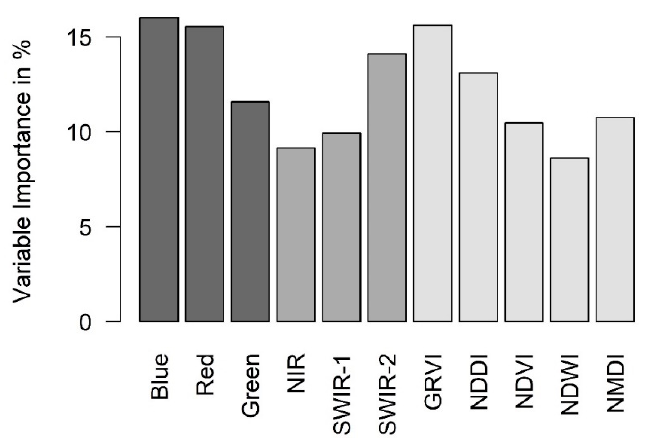
Figure 6. Random forest-based variable importance from model calibration at the 100 m level calculated as the increase in MSE (%) in prediction using variable permutation. Spectral bands of the VIS to SWIR region are represented in dark to medium gray, and spectral indices in light gray.